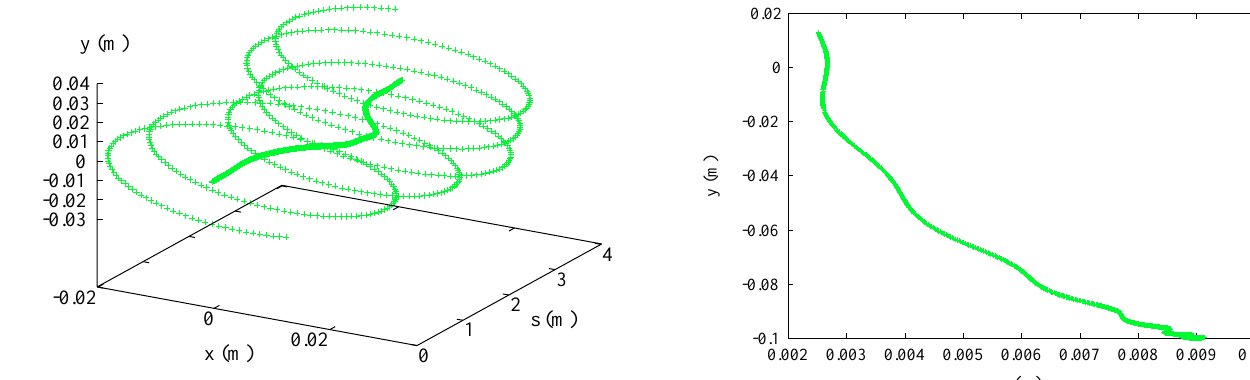
FIG. 7. (Color) The effects of perpendicular momentum, with cusp effects canceled. The particles have an initial of (cid:120) 0 (cid:173) (cid:48)(cid:46)(cid:48) and 0.2. There is a net vertical translation of about 0.01 m in the large angle orbit due to grad B drift. This translation could be canceled with a bend in the opposite direction.